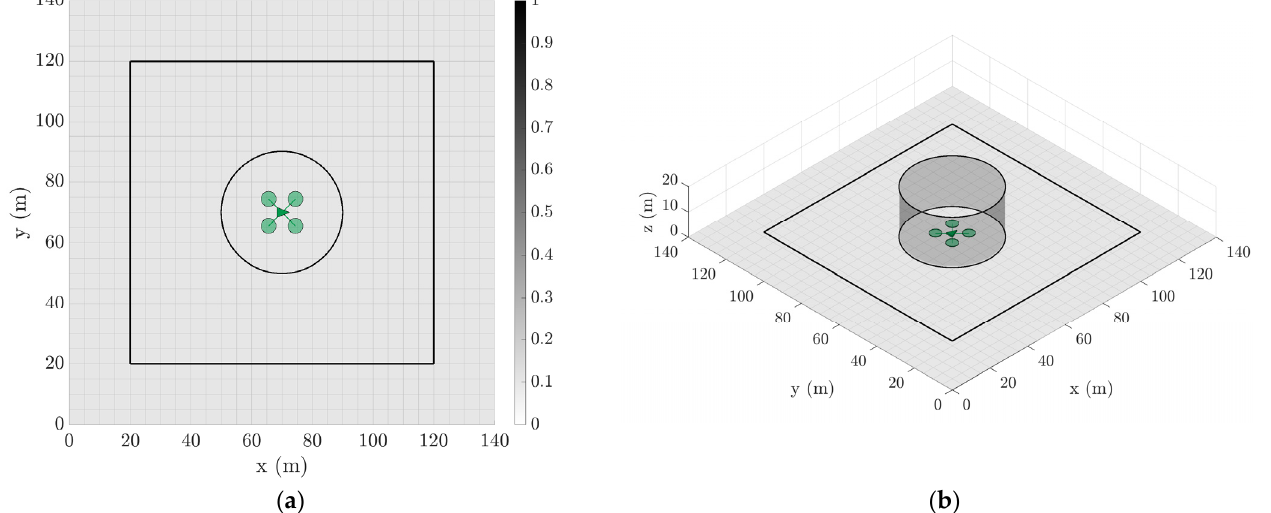
Figure 3. Agent UAV radius of operation sample case R T = 20 m. The maximum range maps to a circle in 2D ( a ) and a cylinder in 3D ( b ). Note the UAV is not drawn to scale. The vertical dynamics of the agents are governed by the relative error between the ground tether points when they are undeployed and a set nominal height value when